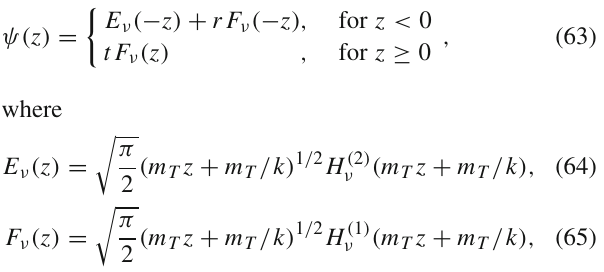
to infinity as ( m T | z | + m T / k ) − 1 / 2 , no fixation of constants C 1 and C 2 produces a convergent solution. Then the massive modes are non-localized. To obtain more information